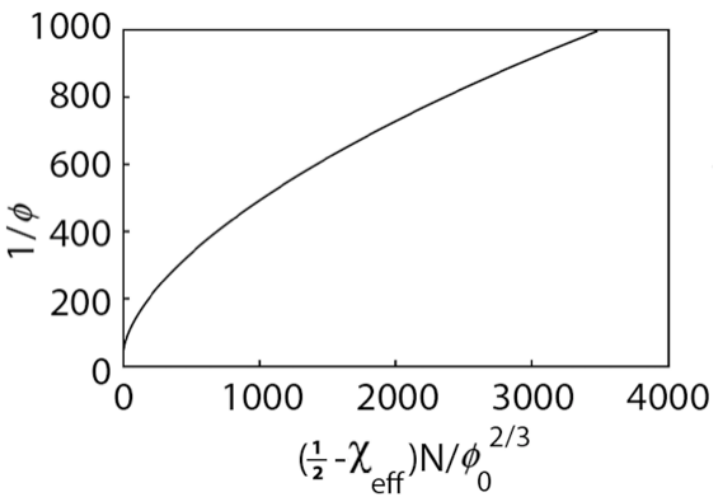
Figure 5. Dependence of the swelling ratio on chain length in the high-salt limit. ( χ eff = 0, φ 0 =